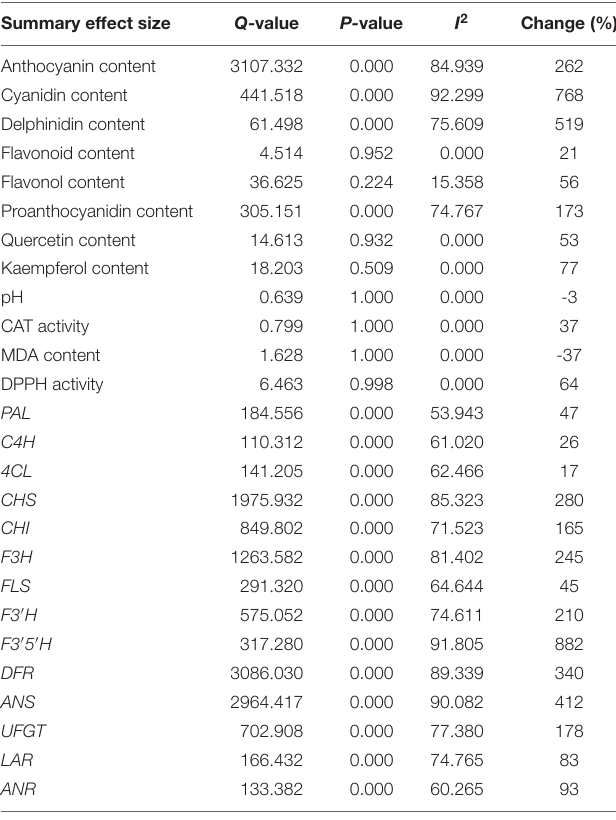
TABLE 2 | Heterogeneity statistics for the 26 summary effect